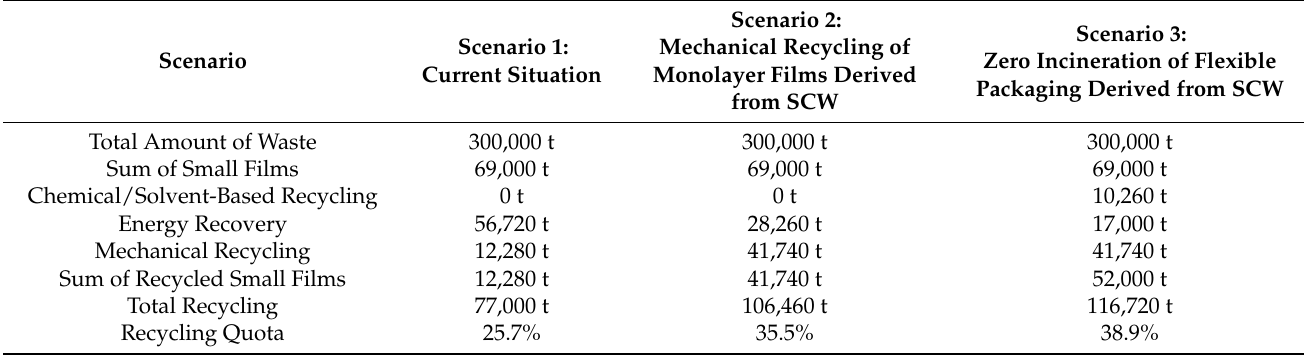
Table 6. Results of the critical factors of all evaluated scenarios in tabular